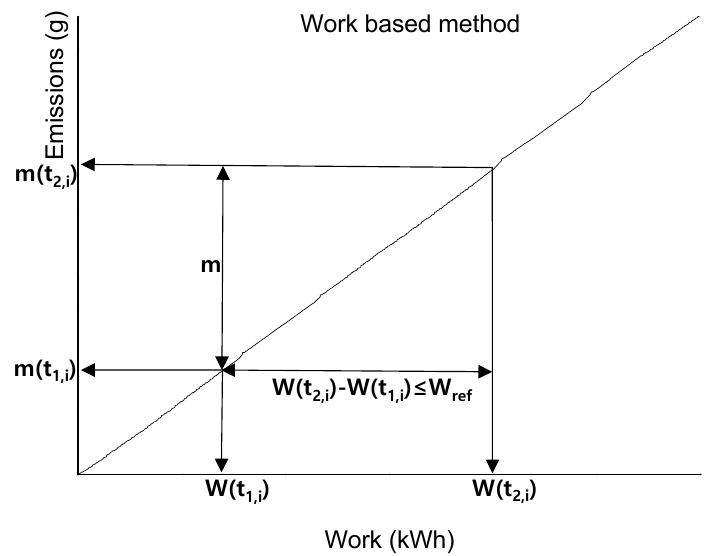
Figure 3. Schematic diagram for the emission with concern of the work with 1 kWh based moving average window (MAW) method.